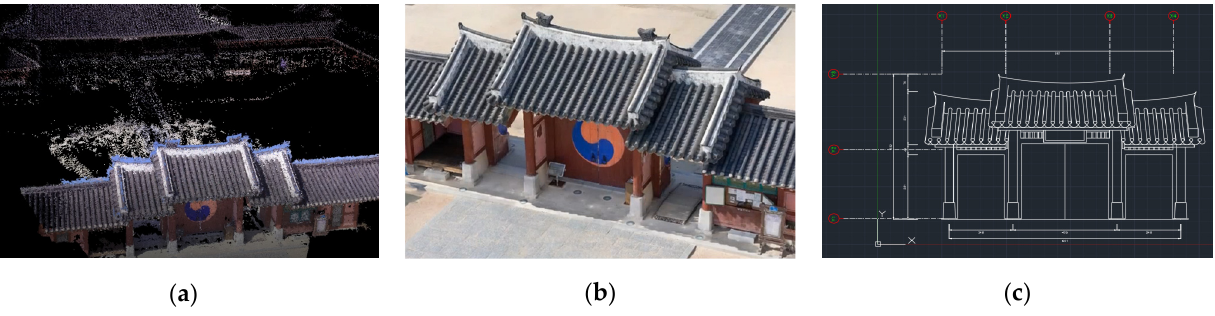
Figure 5. Reverse engineering data by steps: ( a ) Initial point cloud data (PCD); ( b ) 3D modeling data (BIM); and ( c ) Drawing from BIM data.